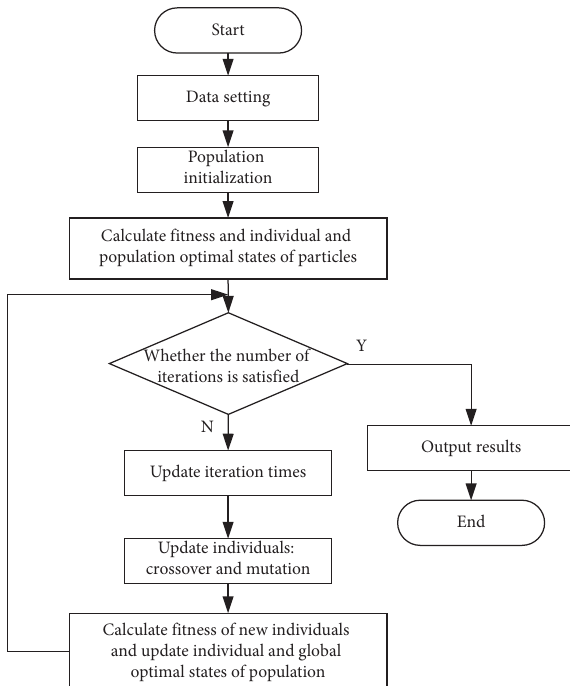
Figure 10: Process of tailored genetic algorithm.